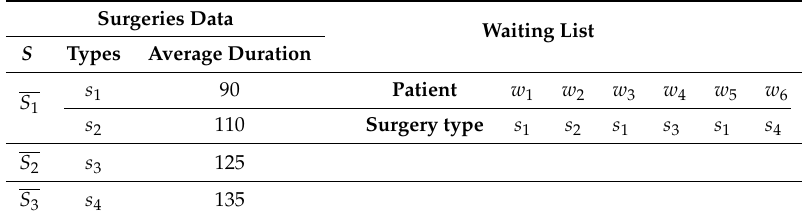
Table 1. Surgery data and waiting list of patients used for explaining part 2 of the SHA.